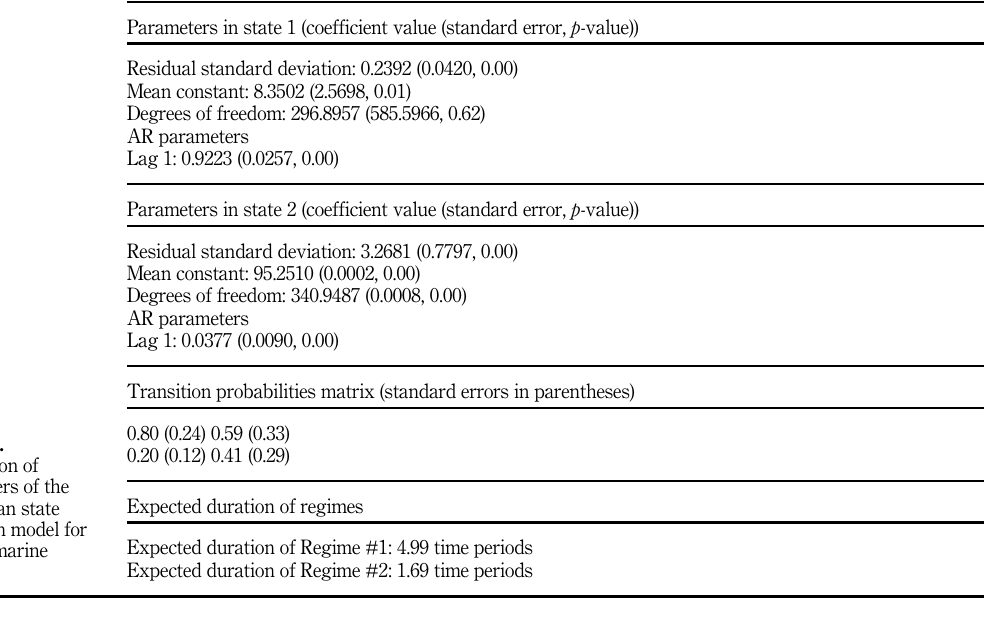
As can be seen from Table 3, the two states simulated by the Markov state transition model are better, the standard deviation of the corresponding residuals, the continuity of the mean and the estimated parameters of the AR model all pass the test; and the transition matrix is obtained, when the economy is in state 1, the probability of maintaining State 1 is 0.80, and the